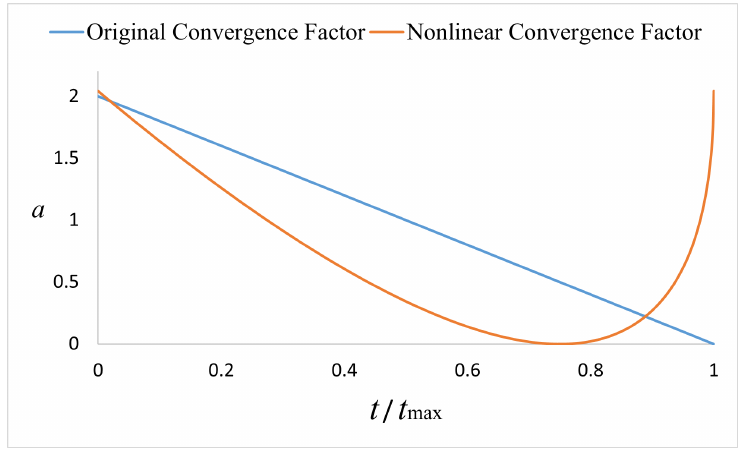
Figure 3. Nonlinear convergence factor.